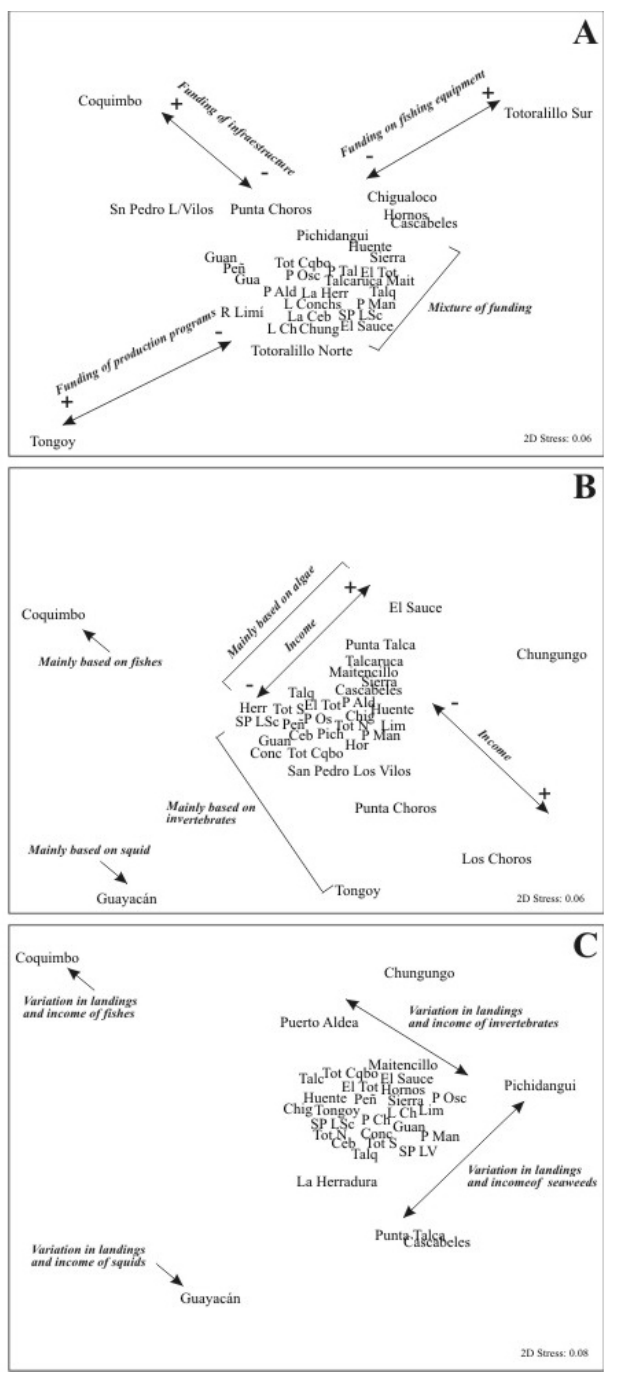
Fig. 7 . Nonmetric multidimensional scaling (nMDS) of funding characteristics (A), characteristics of each caleta (B), and the trends of production and income (C). The vectors show the direction of